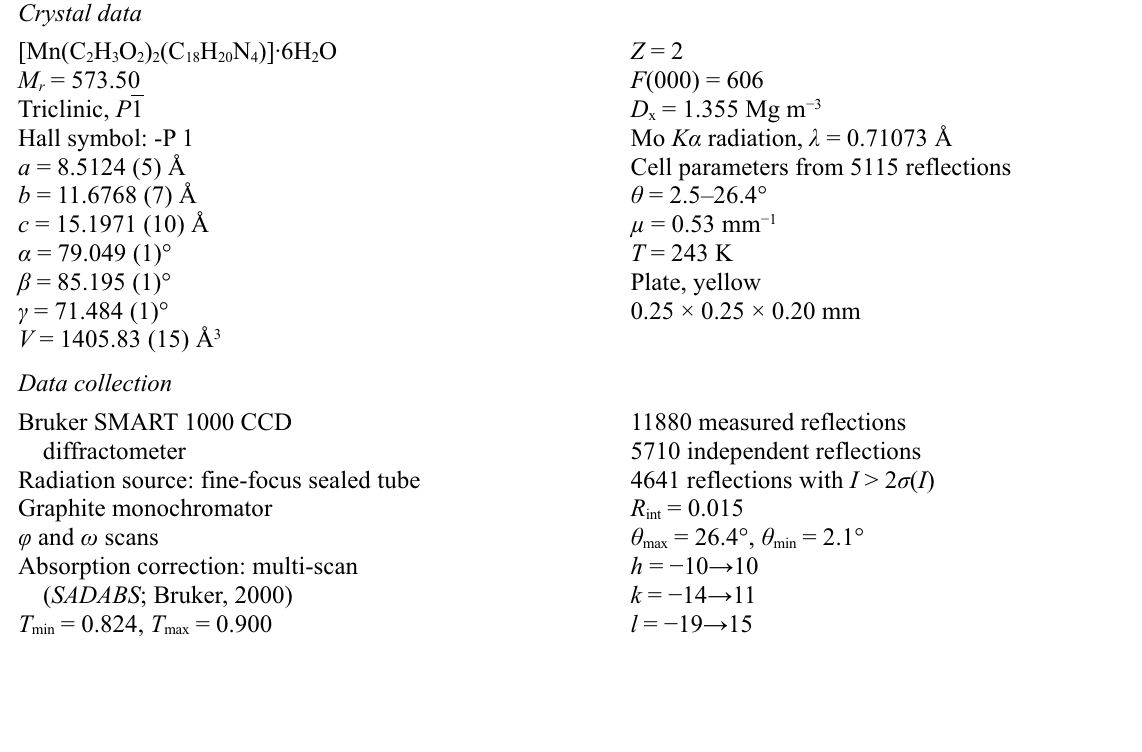
The structure and hydrogen-bond connectivity in the title compound [Symmetry codes: (ii) - x + 1, - y , - z + 1, (iii) - x + 1, - y + 1, - z + 1, (v) x , y + 1, z ]. Hydrogen-bond interactions are drawn with dashed lines. Diacetato[ N , N ′ -bis(2-pyridylmethylidene)cyclohexane-1,2-diamine]manganese(II)